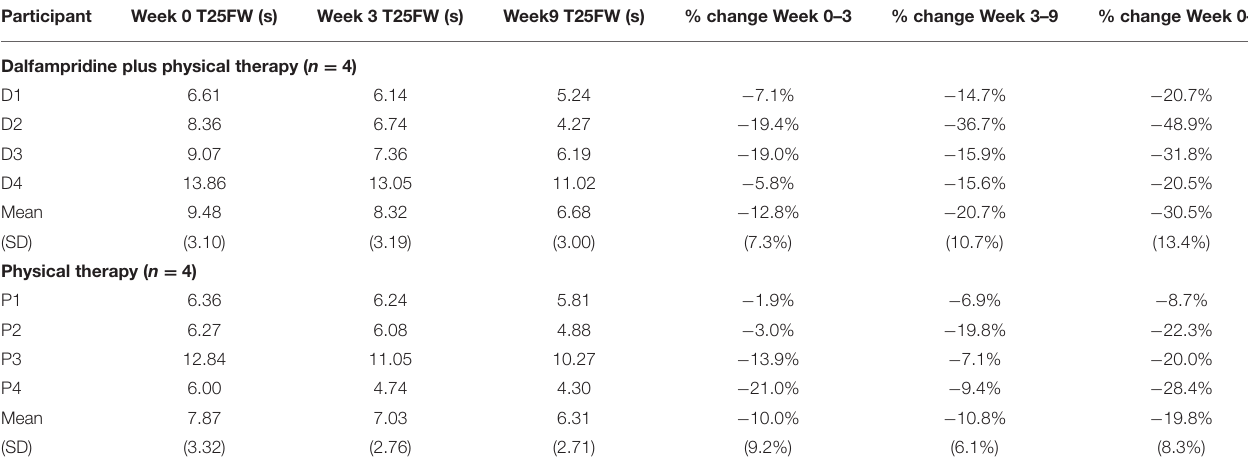
TABLE 2 | Timed 25-foot walk test data by subject and group (faster times are better; negative percentages are improvement).